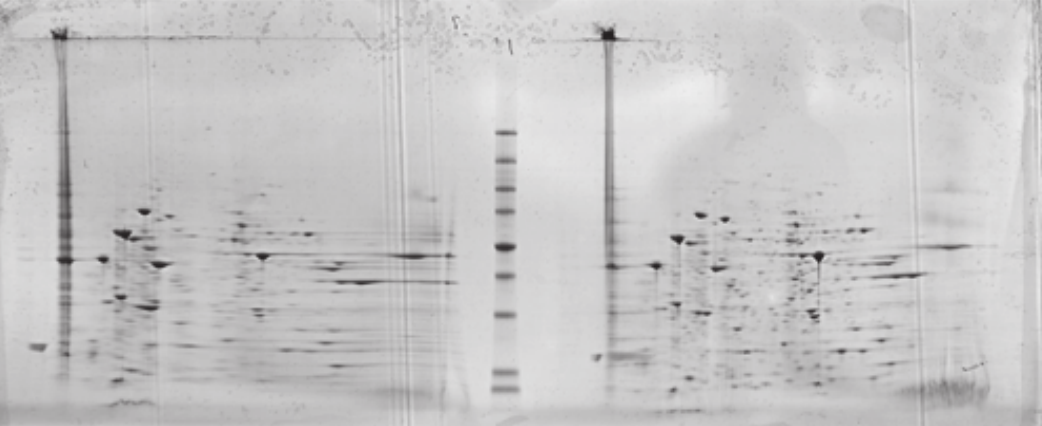
Fig. 1. Example of two-dimensional electrophoresis gel image, selected for protein MW marker detection (the protein standards are located in the middle of the